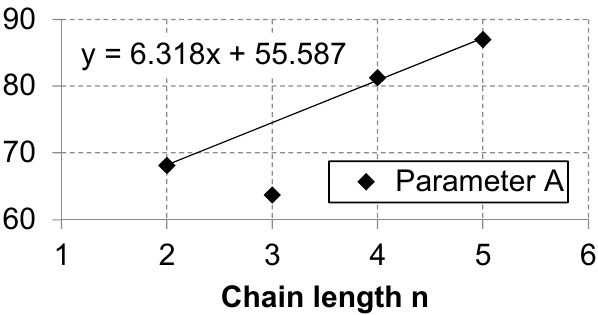
Figure A4. Linear regression of correlation parameter A of the vapor pressure equation (Equation (8)) for OME 2–5 (data given by Boyd [77]).